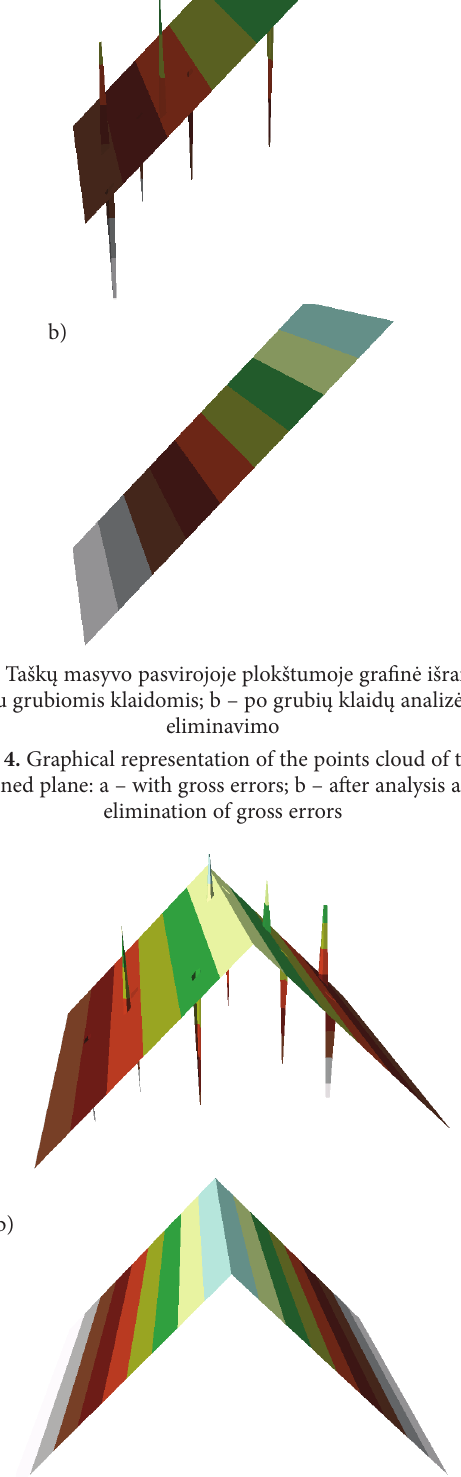
Fig. 5. Graphical representation of the points cloud of the two planes: a – with gross errors; b – after analysis and elimination